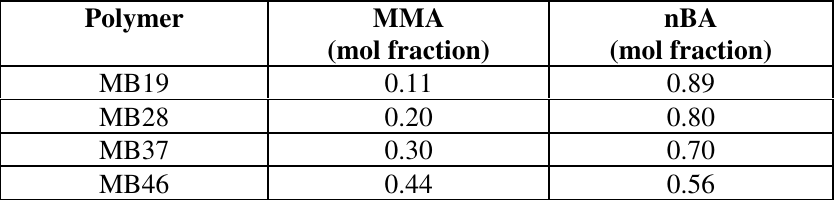
Table 1. The composition of copolymers used for optode